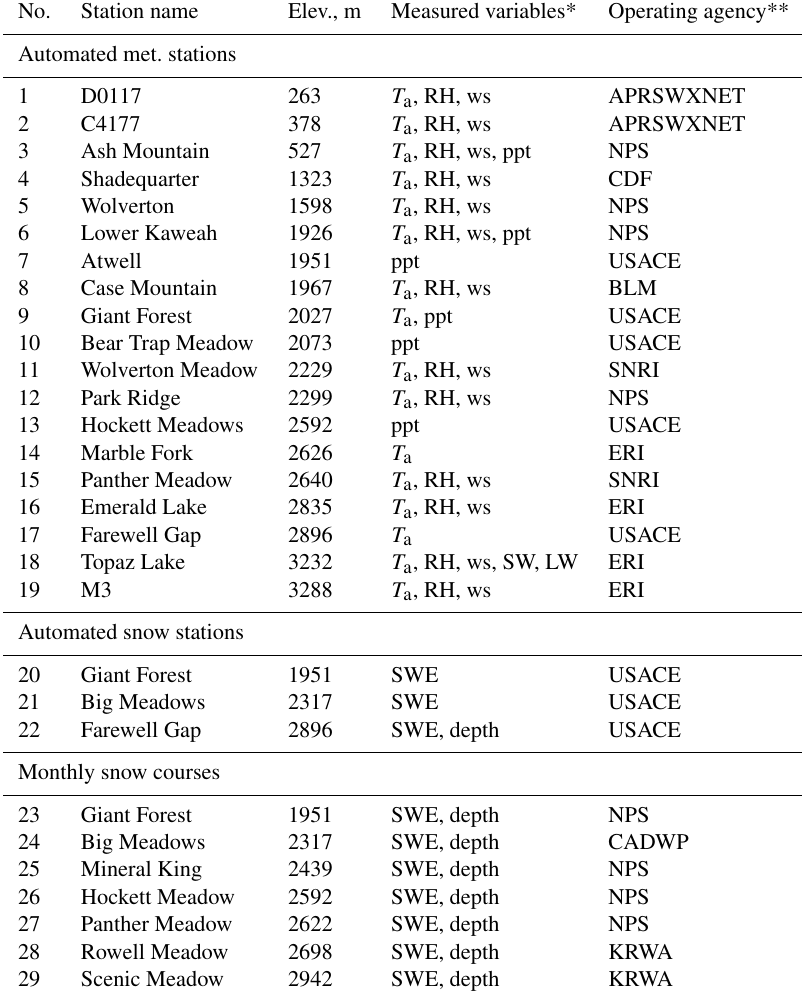
Table 1. Meteorological station and snow measurement details. Station numbers are ranked by station elevation and correspond to those mapped in Fig. 1. The variables measured at each location are listed: air temperature ( T a ), relative humidity (RH), wind speed (ws), precipi- tation (ppt), snow water equivalent (SWE), and snow depth